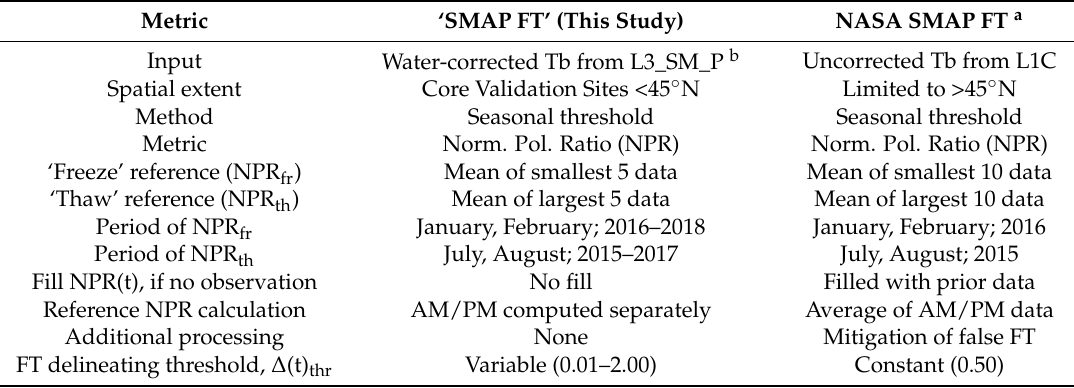
Table 2. Tabular summary of the Freeze/Thaw (FT) delineation algorithm used in this study compared to that used to generate the standard NASA SMAP FT